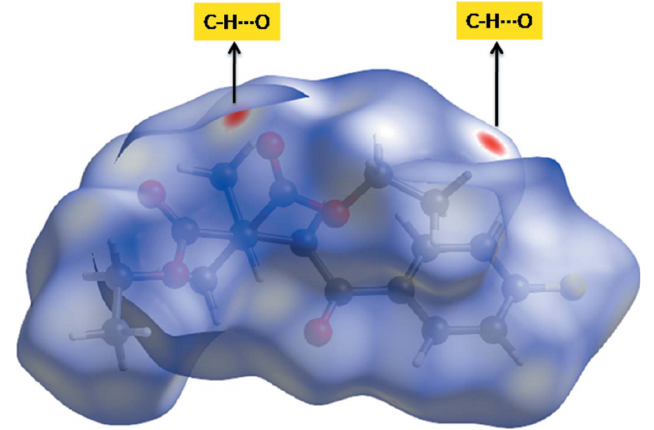
Figure 3 Hirshfeld surface of the title compound mapped over d norm .